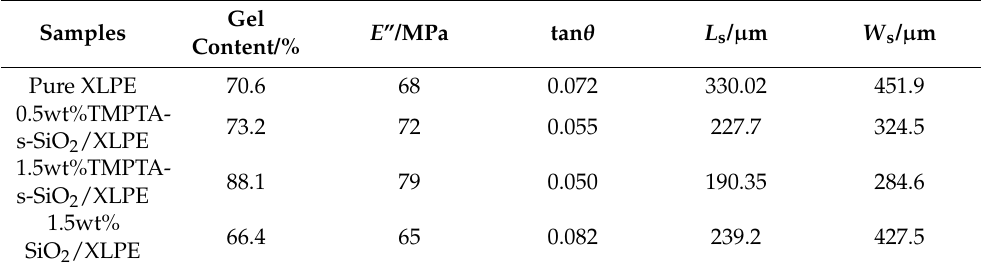
Table 3. Crosslinking degree (gel content), ambient viscoelasticity (loss modulus E ” and factor tan θ ), and water-tree dimension (characteristic length L s and width W s